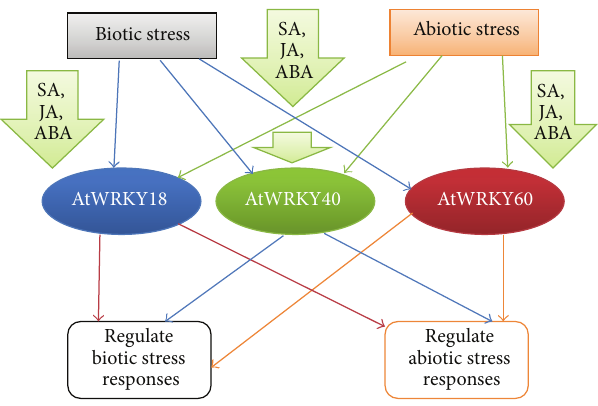
Figure 3: Specific WRKY proteins like AtWRKY18, AtWRKY40, and AtWRKY60 have been depicted as mediators of cross talk between plant responses against abiotic and biotic stresses. It has been reported that these proteins get accumulated in response to SA and JA during biotic stress as well as ABA during abiotic stress